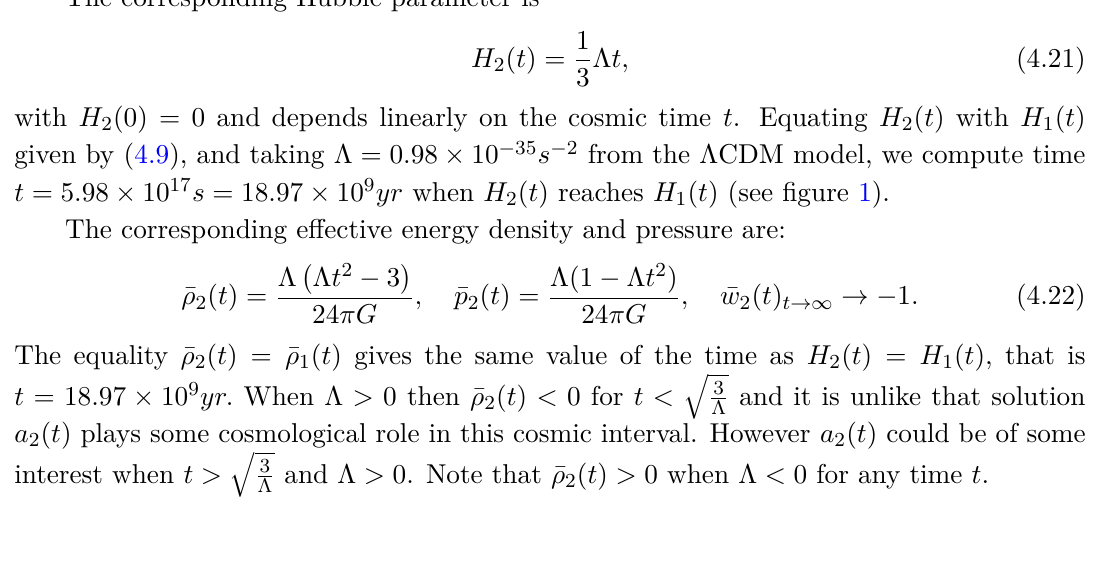
( t ) and H ( t ) are on the right 1 2